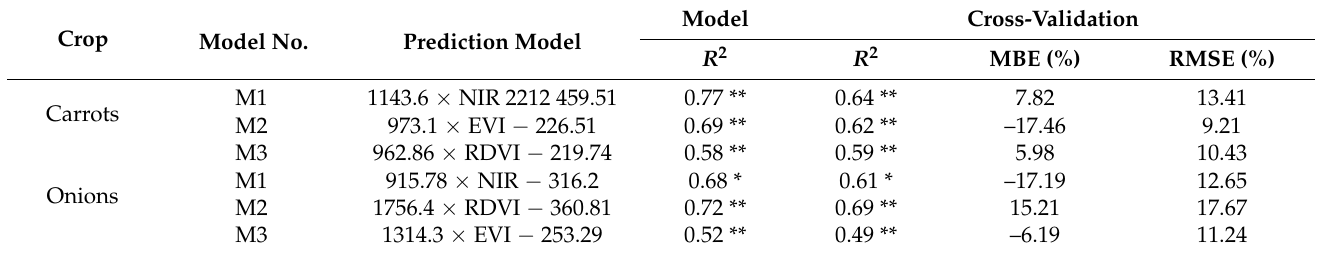
Table 4. Onion and carrot yield prediction models (* significant at 0.05; ** significant at 0.01). Crop Model No.